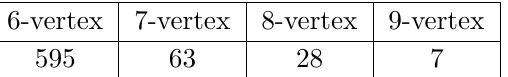
Table 1 . The numbers for various types of vertices in P (3 ; 7), classi(cid:12)ed by the number of facets adjacent to each